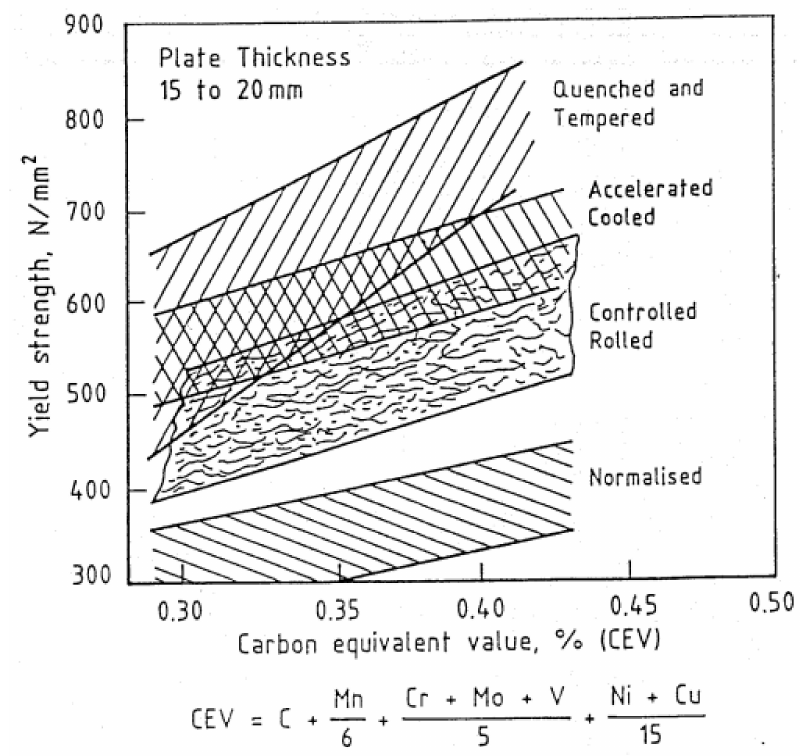
Figure 14. Effect of carbon equivalent value (CEV) and steel processing route on plate strength (This section is re-used/reproduced with permission of the Health and Safety Executive under the terms of the Open Government License, from Ref. [179]. Copyright year: 2003, copyright owner: HSE. Courtesy: HSE & HSE